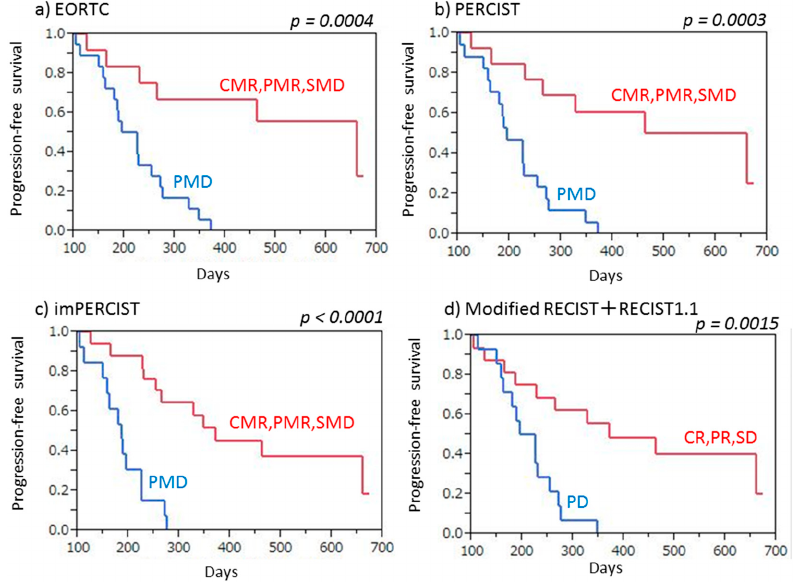
Figure 3. Progression-free survival (PFS) of malignant pleural mesothelioma patients treated by nivolumab therapy, with and without progression. ( a ) EORTC demonstrated that patients with no progression (CMR/PMR/SMD) showed significantly longer PFS than those with PMD ( p = 0.0004). ( b ) PERCIST demonstrated that patients with no progression (CMR/PMR/SMD) showed significantly longer PFS than those with PMD ( p = 0.0003). ( c ) imPERCIST demonstrated that patients with no progression (CMR/PMR/SMD) showed significantly longer PFS than those with PMD ( p < 0.0001). ( d ) Combined modified RECIST and RECIST 1.1 demonstrated that patients with no progression (CR/PR/SD) showed significantly longer PFS than those with PD ( p = 0.0015). Cancers 2021 , 13 , x